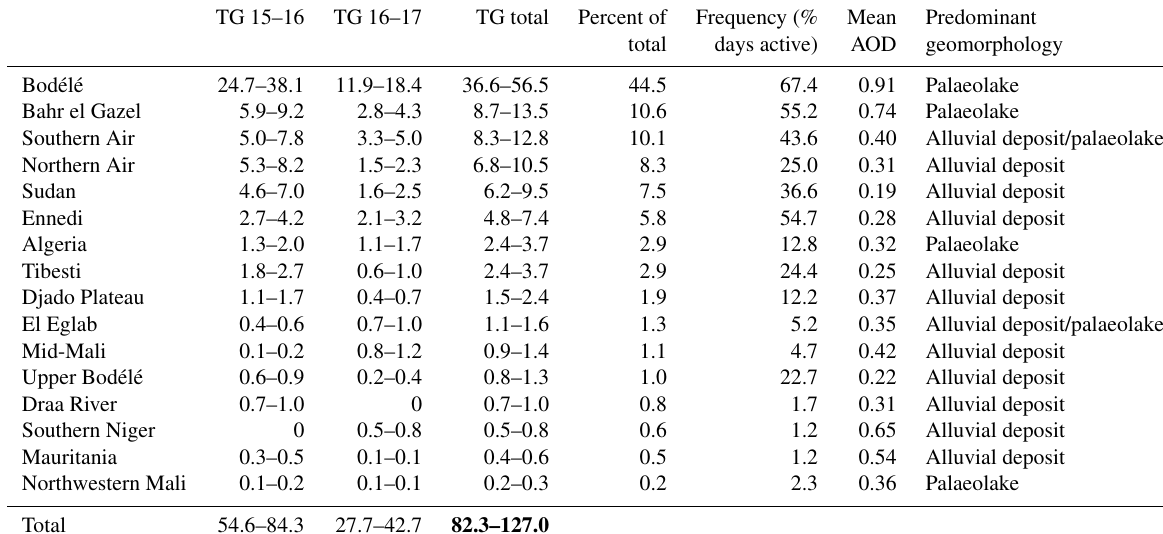
Table 2. Total dust mass emitted per Saharan dust source region during the 2015–2017 winter dust seasons, alongside their predominant geomorphology, mean AOD, and their frequency of